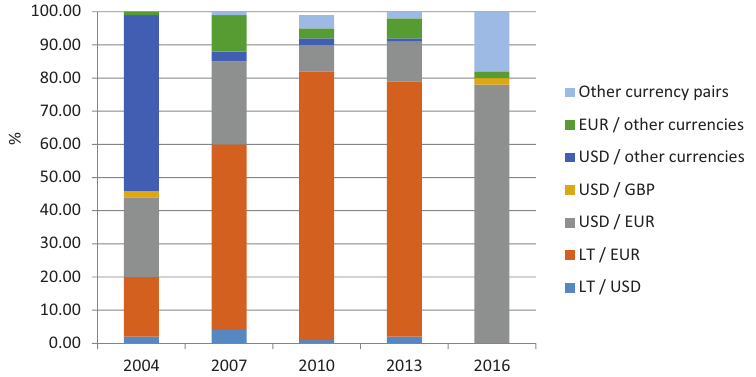
Figure 7. Turnover in the Lithuanian foreign exchange market by currency pairs (source: developed by the authors based on LB, 2016, 2018, 2019a; BIS, 2018a, 2018b)